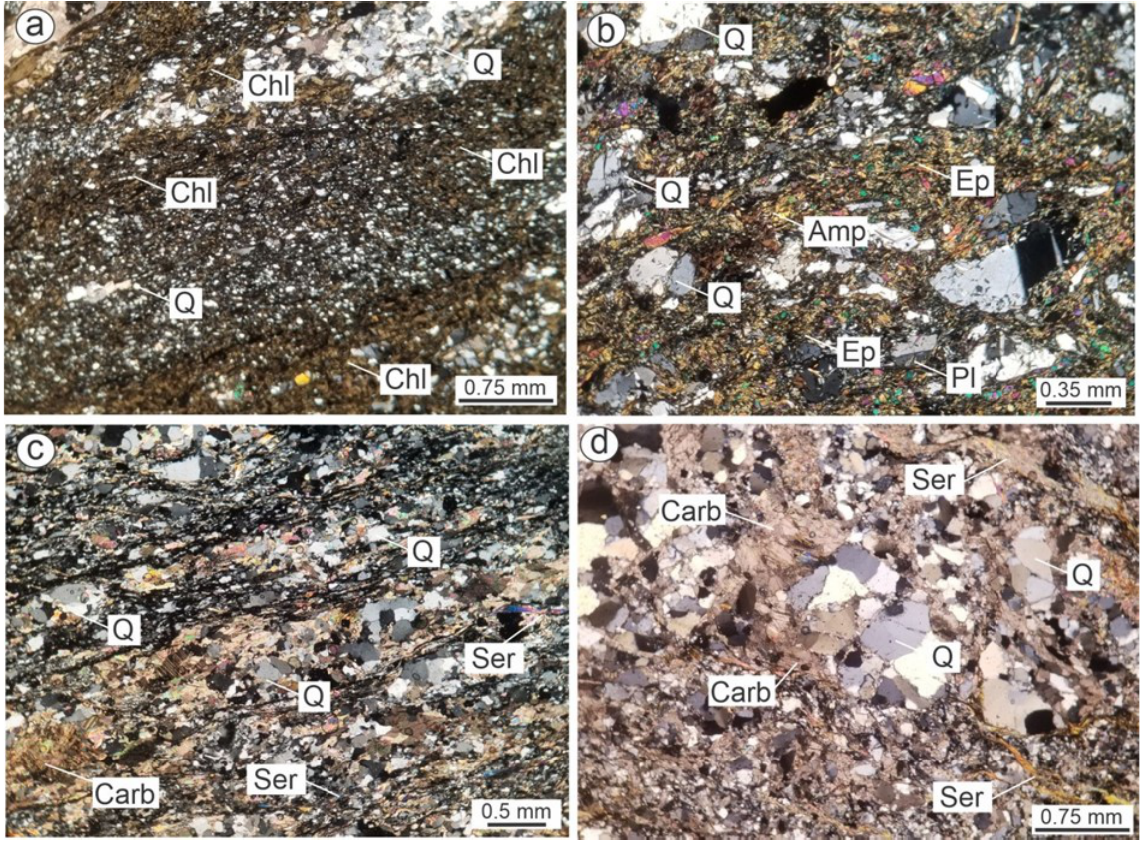
Fig. 5. Representative microphotographs of metamorphic rocks from the Emgentiin Bulag area. a) Quartz-chlorite schist (sample E6), b) Amphibole-chlorite schist (sample E7), c) Quartz-sericite schist (sample E2), d) Schistose sandstone (sample E4). Abbreviations: Q – quartz, Pl – plagioclase, Amp – amphibole, Ep – epidote, Chl – chlorite, Mus – muscovite, Ser – sericite, Carb – carbonate. All photomicrographs are under cross-polarized